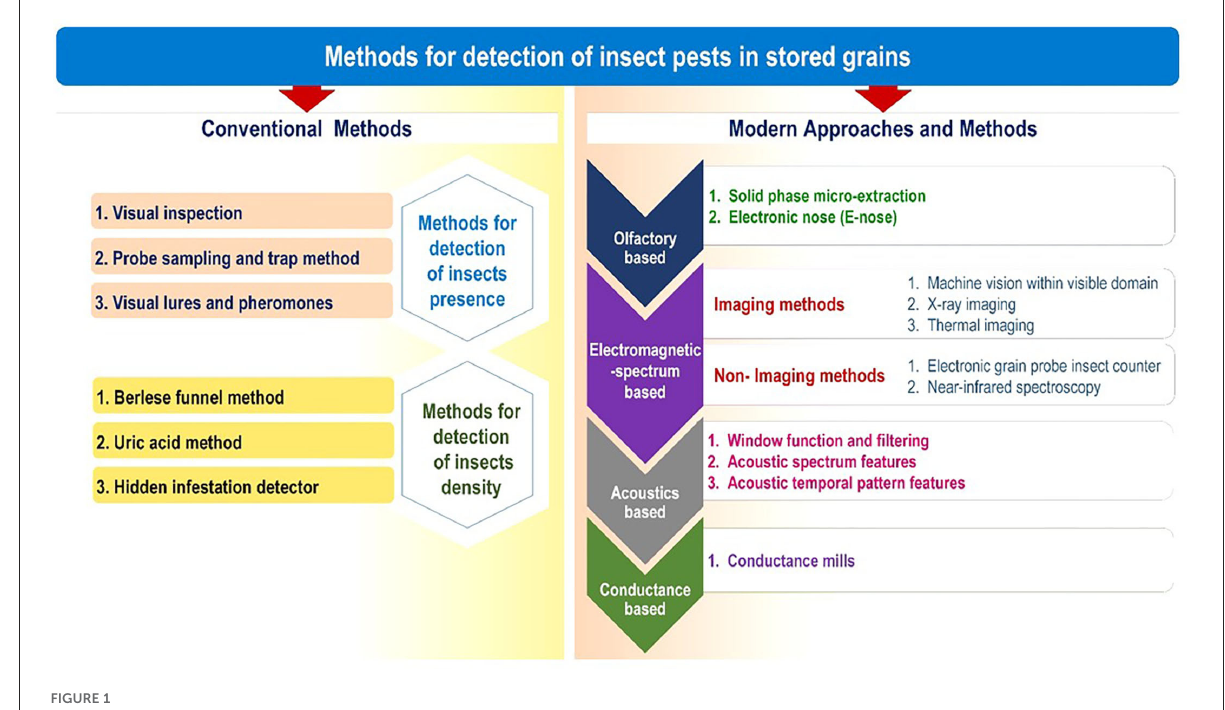
FIGURE1 Methods for insect pests detection in